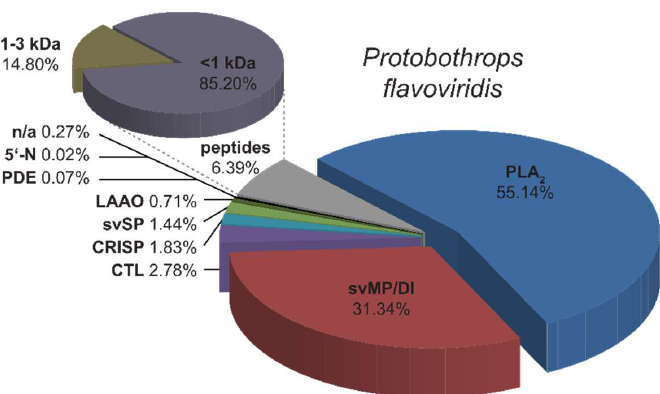
Figure 3. Semi-quantitative venom composition of P. flavoviridis . Relative occurrence of different toxin families and peptide content in P. flavoviridis : Phospholipases A 2 (PLA 2 , blue), snake venom metalloproteinases and disintegrins (svMP/DI, red), C-type lectin-like proteins (CTL, violet), cysteine rich secretory proteins (CRISP, light blue), snake venom serine proteases (svSP, light green), L -amino acid oxidases (LAAO, dark green). Phosphodiesterases (PDE), 5′-nucleotidases (5′-N) and some unidentified proteins (n/a) (combined in black and peptides in grey) are less abundant. Groups of different peptide sizes are summarized in an additional pie chart percental related to the total peptide content. They were clustered to <1 kDa (dull purple) and 1–3 kDa (dull brown) parts.